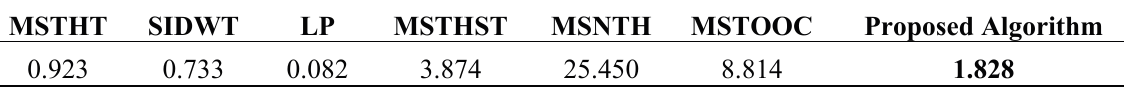
Table 1. Processing time comparison